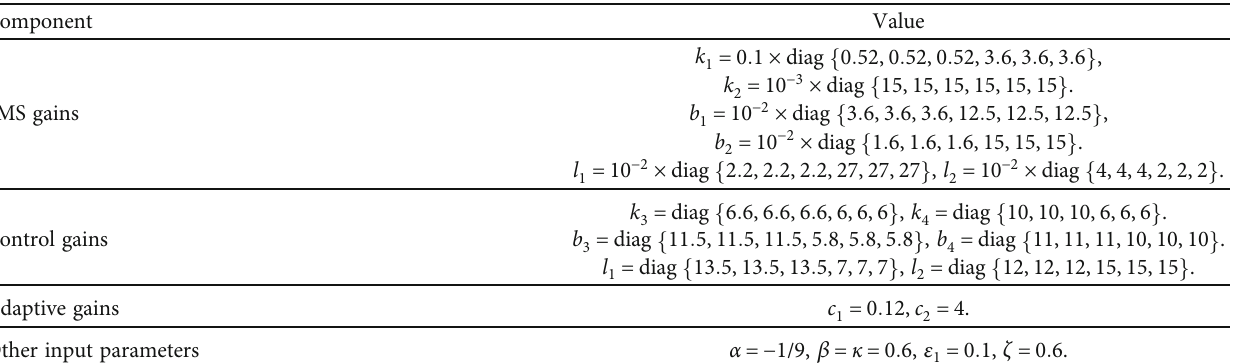
Table 5: Gains of the three control